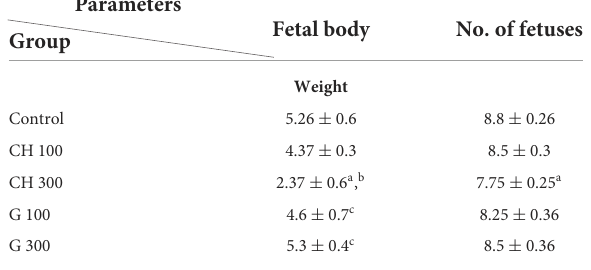
TABLE 2 Effect of chemical and green TiO 2 NPs on fetal body weight (g/kg) and the number of fetuses of control and experimental groups (mean ± SD).